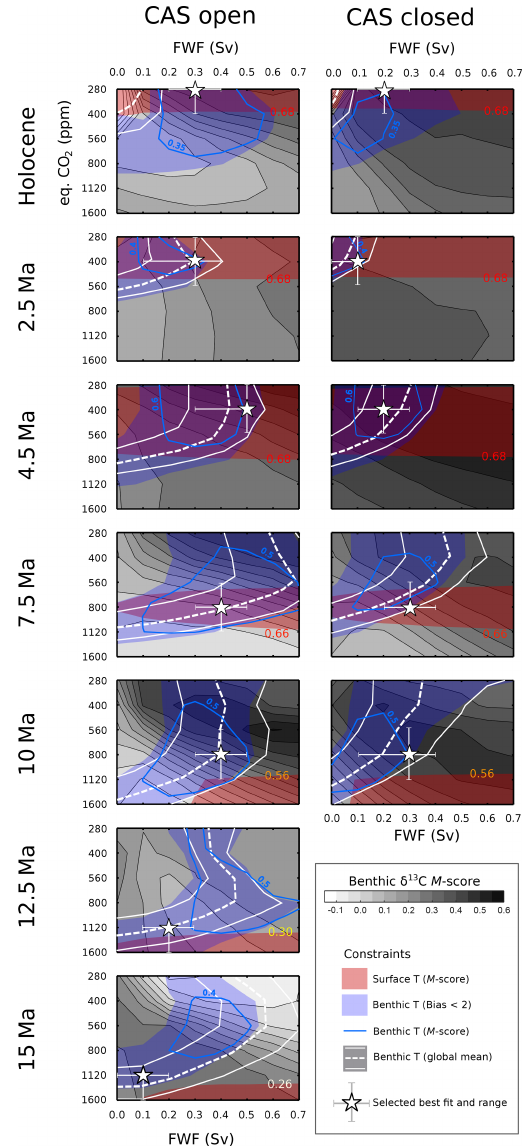
Figure 6. All proxy data constraints combined. The M-score for the modelled benthic δ 13 C fit to the data set is shown using filled con- tours (grey). The modelled benthic global mean temperature nearest to that identified in Cramer et al. (2011) is shown using a dashed white line, with the maximum and minimum estimates shown as solid thin white lines. The benthic temperature constraint is shown using blue; the blue filled region is where modelled benthic temper- ature has a bias of less than < 2 ◦ C with respect to the δ 18 O-derived temperature data (or the WOA 2009 for the Holocene), and the blue contour indicates the M-score, with the value given in blue. The M- score contour for the modelled surface ocean temperature fit to data is shown using red shading, with the value marked on the edge of the contour. The overall best fit settings are shown using a white star, with the upper and lower range estimates shown using